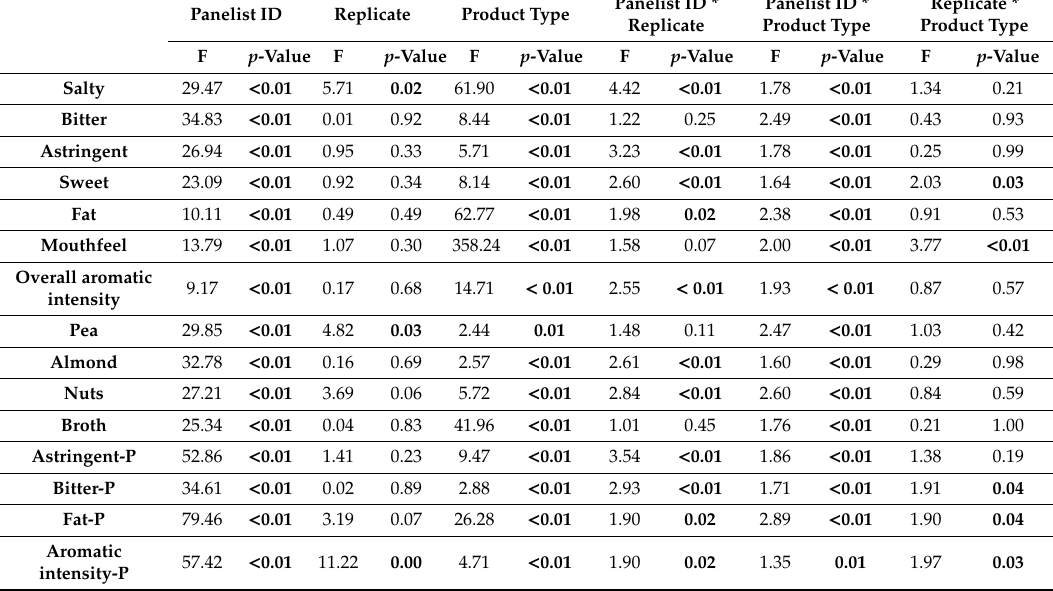
Table 3. Results of the three-way ANOVAs (panelist ID, replicate, and product type as fixed e ff ects + their first-order interactions) examining consistency in panelist performance (total degrees of freedom: 739; residual degrees of freedom: 681). Significant p -values are in bold ( α = 0.05). Abbreviations: Astringent-P = persistence of astringency; Bitter-P = persistence of bitterness; Fat-P = persistence of fattiness; and Aromatic intensity-P = persistence of overall aromatic intensity.